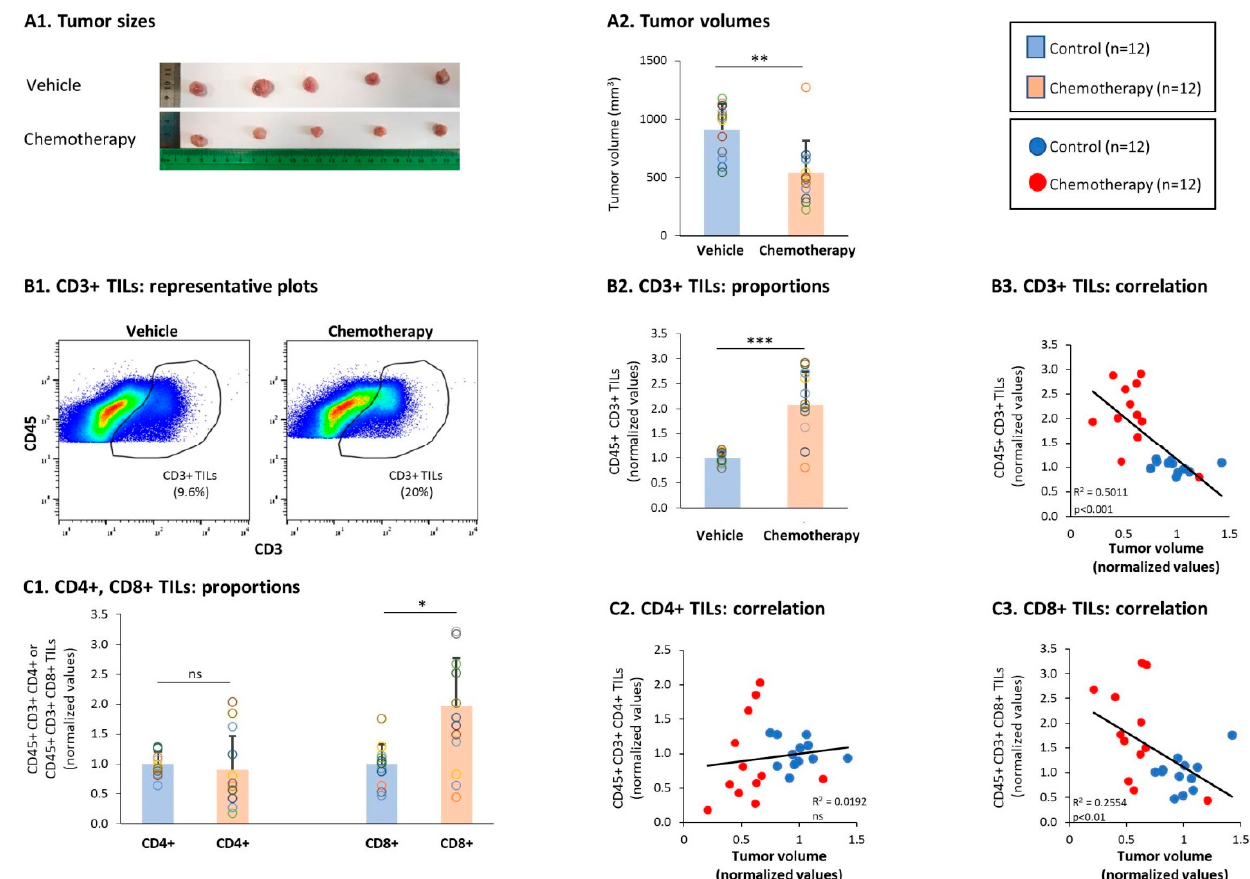
Figure 3. Chemotherapy reduced TNBC tumor growth and elevated the levels of CD3+ and CD8+ TILs. Murine 4T1 TNBC cells were syngrafted to the mammary fat pads of female BALB/c mice; one group of mice received chemotherapy (doxorubicin + paclitaxel) and the other group received the vehicle of the drugs; n = 12 in each group, in total in 3 biological repeats. Chemotherapies were given as described in the Materials and Methods section until the termination of experiments on day 19. ( A ) Tumor sizes. At the end of the experiments, tumor volumes were determined and the tumors were photographed. ( A1 ) Tumors excised at the end of the third experiment, demonstrating the tumor sizes in the two groups, n = 5 mice in each group. ( A2 ) Average ± SD of tumor volumes in each group. ( B ) CD3+ TILs, gated out of CD45+ cells. ( B1 ) Representative flow cytometry analyses of CD3+ TILs. ( B2 ) Proportions of CD3+ TILs. ( B3 ) CD3+ TILs correlated with tumor volumes. ( C ) CD4+ TILs and CD8+ TILs, gated out of CD45+ CD3+ cells. ( C1 ) Proportions of CD4+ TILs and CD8+ TILs. ( C2 , C3 ) CD4+ TILs and CD8+ TILs, respectively, correlated with tumor volumes. Gating procedures are described in Figures S1 and S2 and in “Section 2”. In the proportion and correlation analyses, the average value of the vehicle-treated group in each biological repeat was given the value of 1 and the values of all mice analyzed in that repeat were normalized accordingly. The value of each mouse is presented as a dot. *** p < 0.001, ** p < 0.01, * p < 0.05, ns: not significant (two-tailed unpaired Student’s t -test; correlation analyses: Pearson;